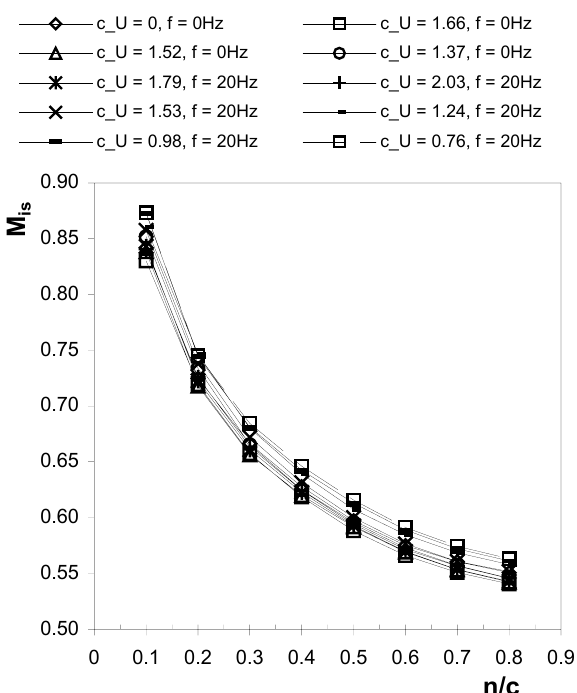
Fig. 9. Sequence of schlieren pictures taken at incidence